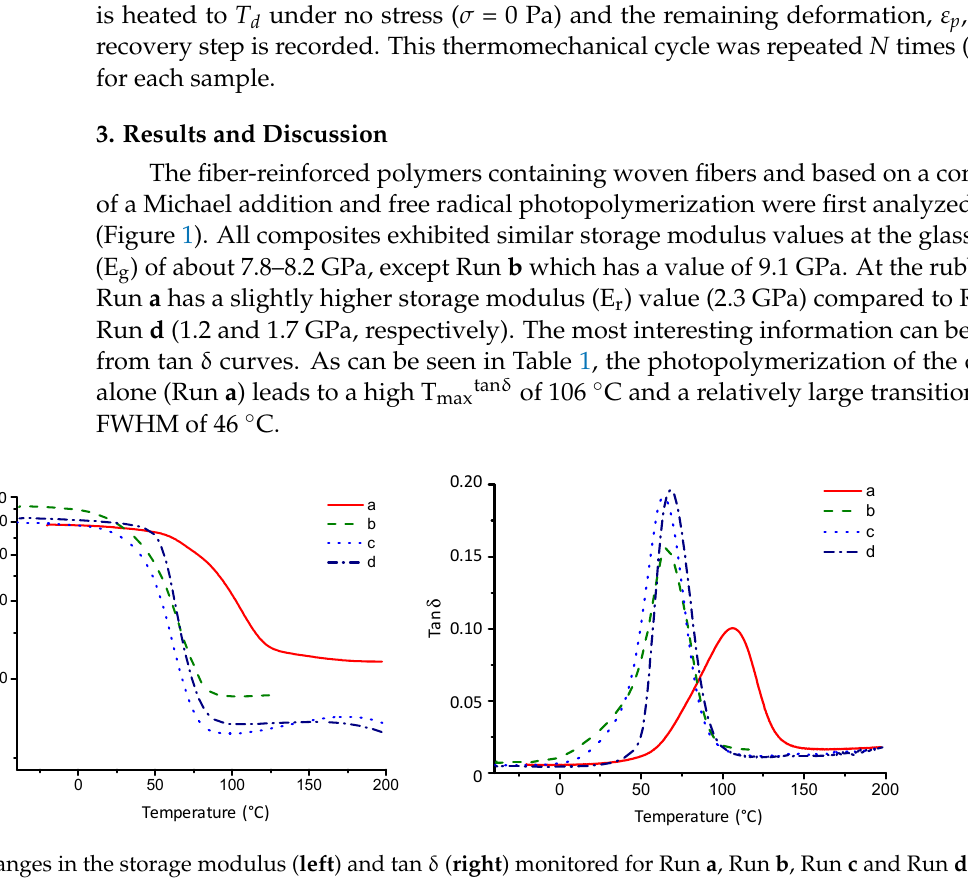
Table 1. Storage moduli measured at the glassy plateau (E g ) and rubbery plateau (E r ), maximum temperature T maxtan δ and the full width at half maximum (FWHM) of the tan δ curve. Dynamical mechanical analysis was made using the single-cantilever (16.47 mm) mode between − 40 ◦ C to 200 ◦ C using a Q800 from TA Instruments (New Castle, DE, USA) on 30 × 11 mm 2 samples at a rate of 2 ◦ C/min, a deformation of 20 µ m and a frequency of 1 Hz.